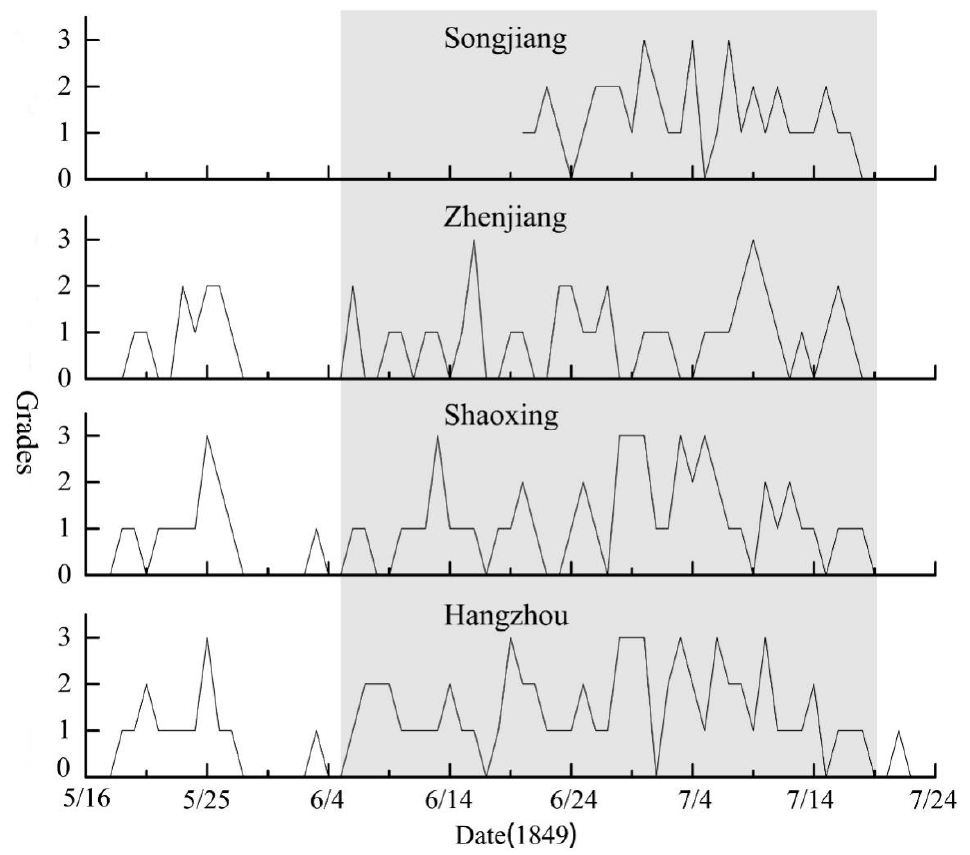
Figure 4. Records of four sites of diaries. The daily weather classification method during Meiyu period in 1849 adopts the method of Zhimin Man et al. [50] with some amendments. 0: sunny, 1: light rain, 2: moderate rain, 3: rainstorm. The gray area is Meiyu period.